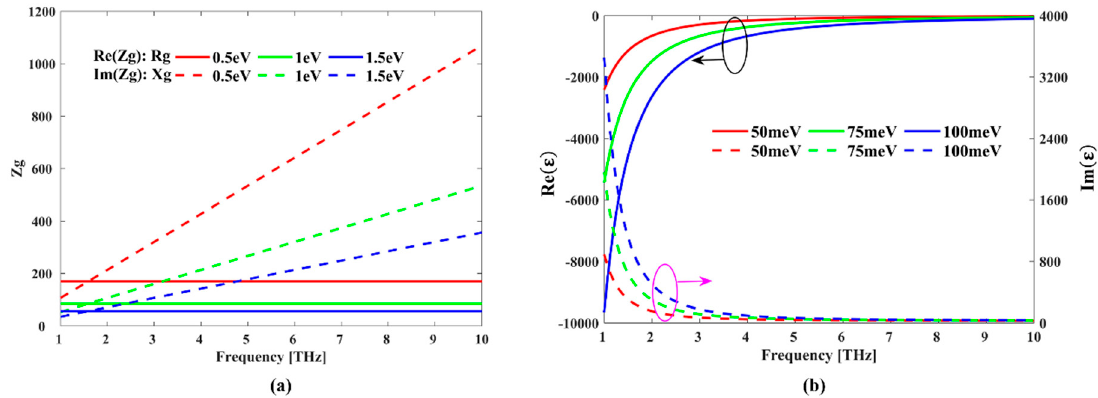
Figure 1. ( a , b ) Frequency-dependent surface impedance Zg of graphene and permittivity of bulk Dirac semimetal (BDS) at different Fermi energies, respectively.